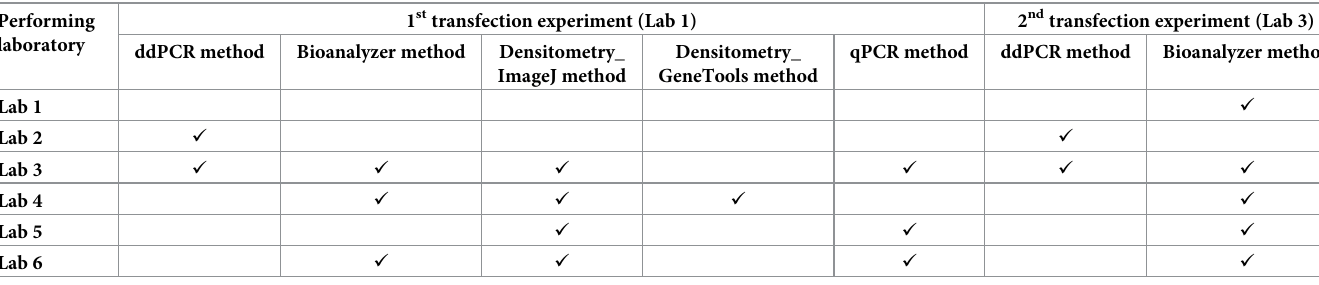
Overview of the technologies performed by the different laboratories. Four protocols were included for the 1 st transfection experiment and the two most promising technologies (ddPCR and single round RT-PCR combined with bioanalyzer quantification) were replicated with samples of the 2 nd transfection experiment. ddPCR = digital droplet PCR and qPCR = quantitative real-time